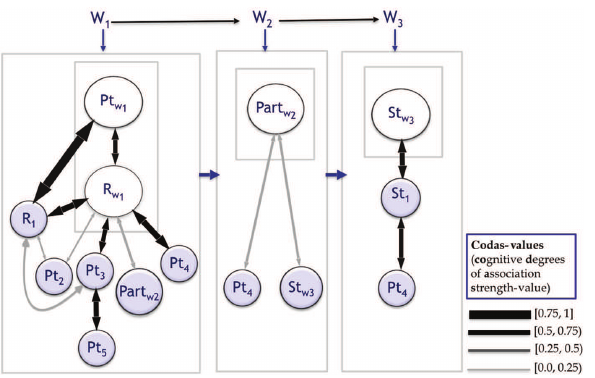
Figure 4: Local Associative Subnetworks of a Query Consisting of Three Keywords: Q = ⟨ W 1 , W 2 , W 3 ⟩ .